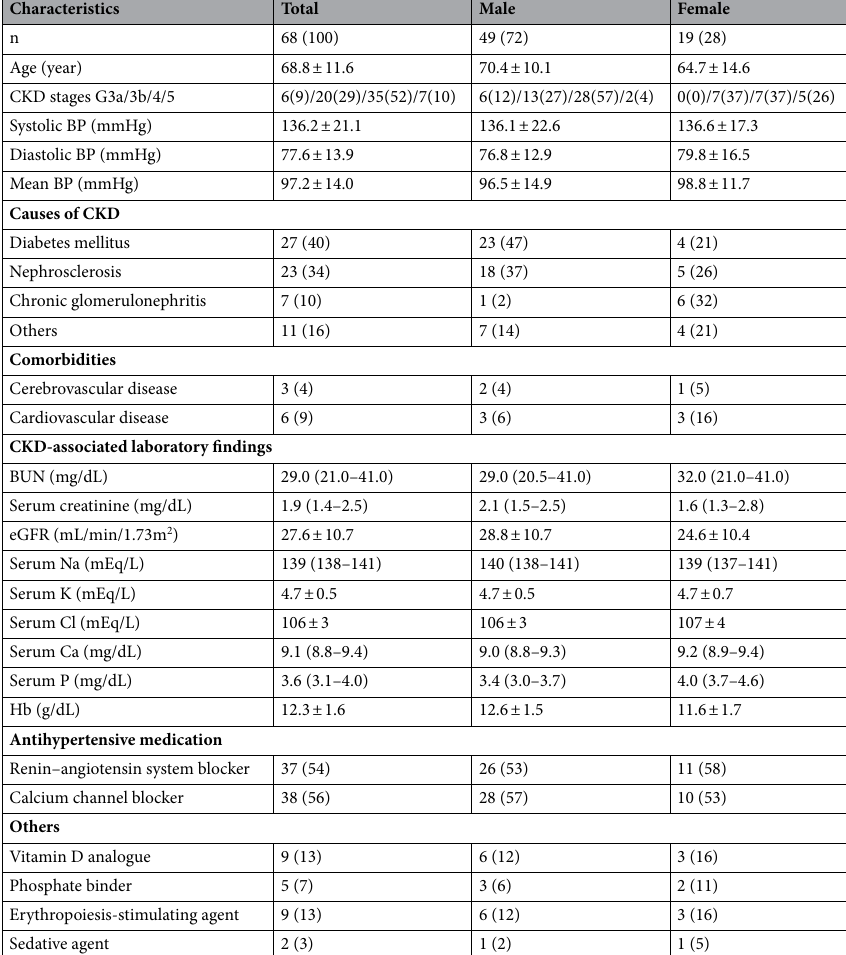
Table 4. Patient characteristics. Categorical data are presented as number (%), continuous data are presented as mean ± standard deviation or median and interquartile range. BP blood pressure, BUN blood urea nitrogen, CKD chronic kidney disease, eGFR estimated glomerular filtration